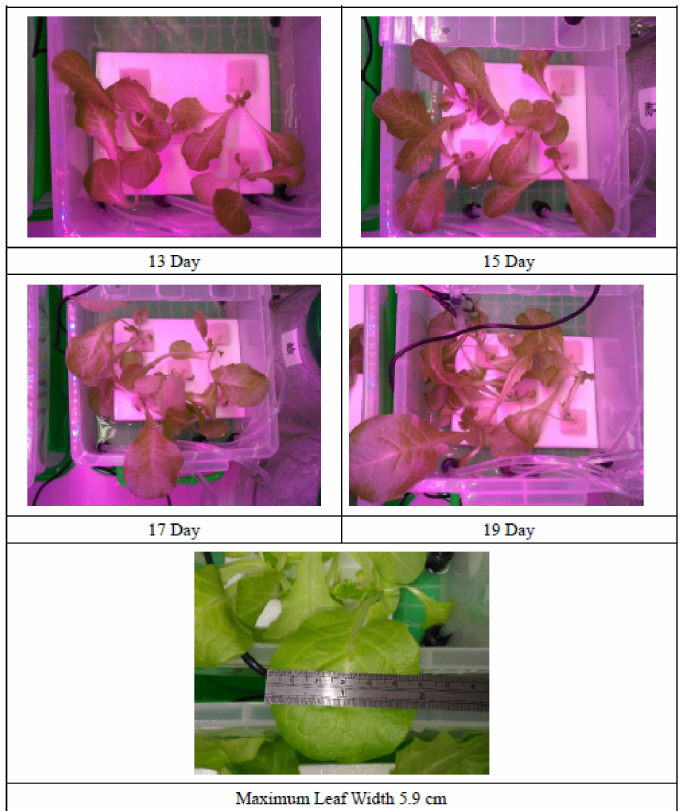
Figure 8. Results of initial nutrient solution